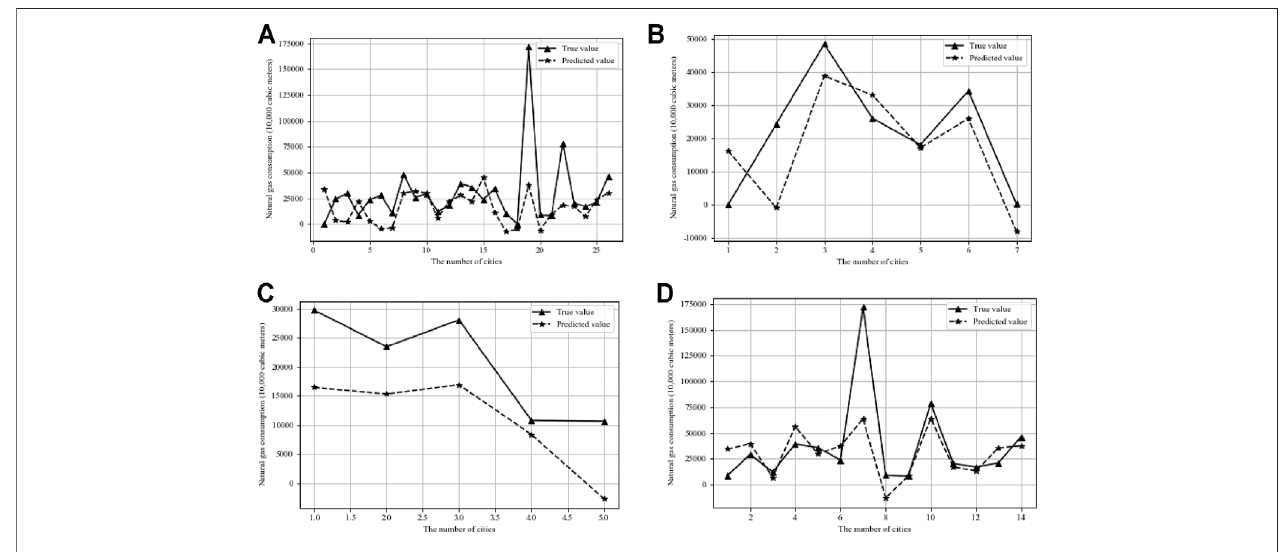
FIGURE 7 | Linear projection results for urban household gas consumption.